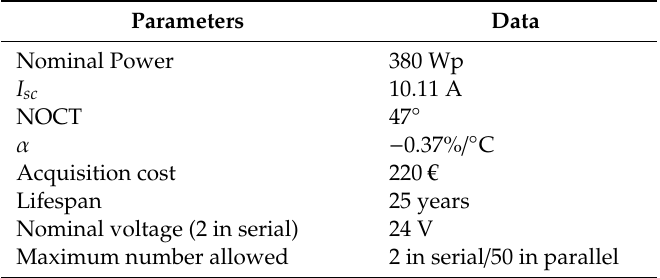
Table 5. PV modules considered in the optimization.